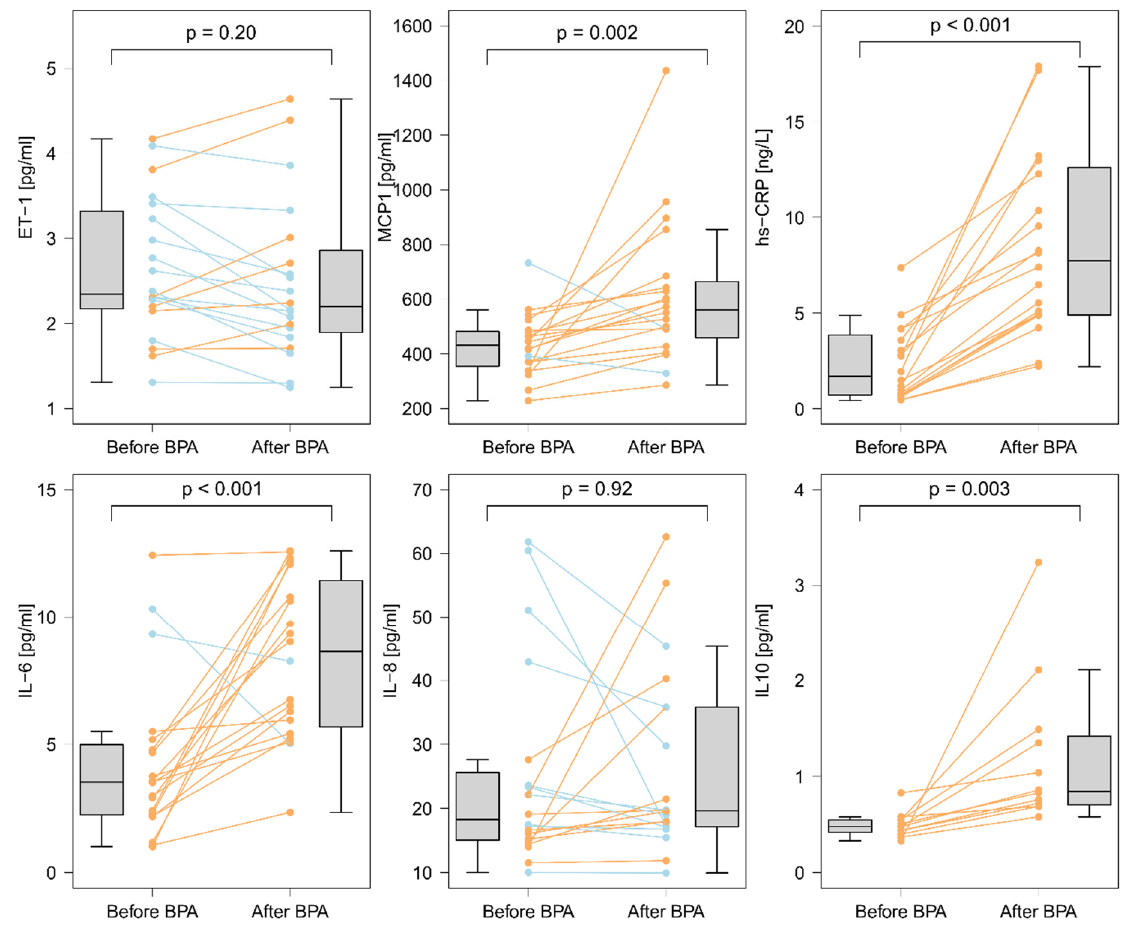
Figure 1. Serum concentrations of biomarkers before and 24 h after a single BPA session. There were increases in concentrations of IL-6 ( ∆ = 3.67 (1.41; 7.16); p < 0.001), of IL10 ( ∆ = 0.25 (0; 0.47); p = 0.003), of MCP-1 ( ∆ = 111 (60.1; 202.8); p = 0.002), and of hsCRP ( ∆ = 4.81 (3.46; 8.47); p < 0.001), and no change in IL-8 ( ∆ = 0.12 ( − 5.44; 5.23); p = 0.92), or ET-1 ( ∆ = − 0.2 ( − 0.5; 0.23); p = 0.20). The orange color indicates an increase, and the blue color indicates a decrease. The difference between the two time points was determined using the Wilcoxon matched-pairs signed-rank test.